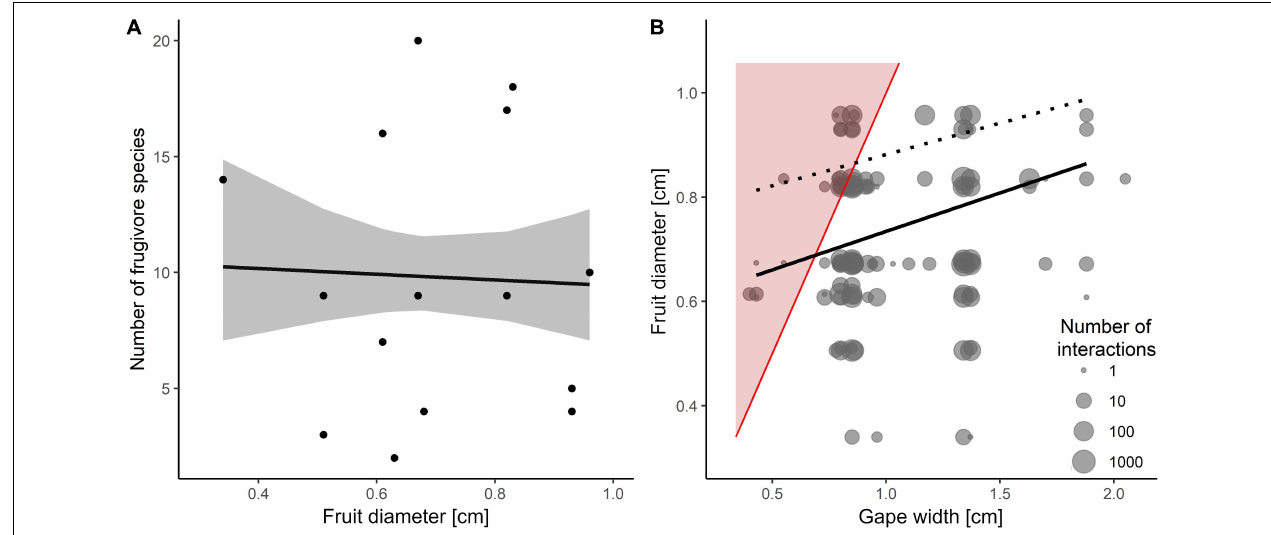
FIGURE 4 | (A) The effect of fruit diameter on the number of disperser species per plant species. The gray-shaded area indicates 95% confidence intervals. (B) The maximum and mean diameter of fruits of plant species dispersed by animals with different gape widths during fruit removal observations (Albrecht et al., 2013; Schlautmann et al., 2021) in Białowie˙za Forest, Poland. The red-shaded area displays morphological “forbidden links” between plants and animals based on mean